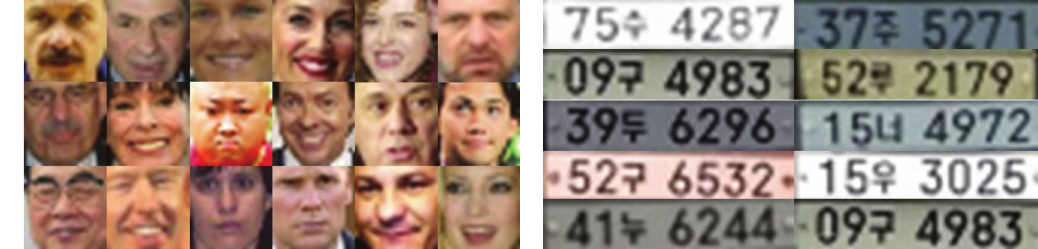
Figure 6: Training image examples of faces and license plates.